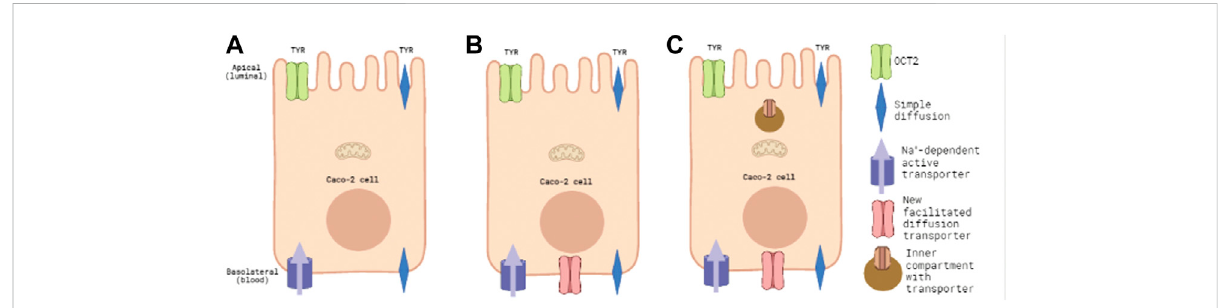
FIGURE 1 Known and predicted TYR transporters used for modelling transcellular passage in Caco-2 cells. Panel 1 (A) represents the baseline model of known TYR transport processes in the Caco-2 intestinal cell line, where TYR can cross Caco-2 plasma membranes by simple diffusion, be transportedacrosstheapical membrane bythebi-directional facilitated diffusiontransporterOCT2,oractivelyaccumulated withinthecellfromthe basolateral compartment by an as yet unidenti fi ed Na + -dependent active transporter. Panel 1 (B) represents the model where an additional facilitated diffusion transporter in the basolateral membrane has been added and optimal kinetic parameters that maximized consistency with experimental concentration-time relationships determined. Panel 1 (C) represents the model where an intracellular compartment is introduced to sequester uptaken TYR as an alternative to assymetric facilitated diffusion